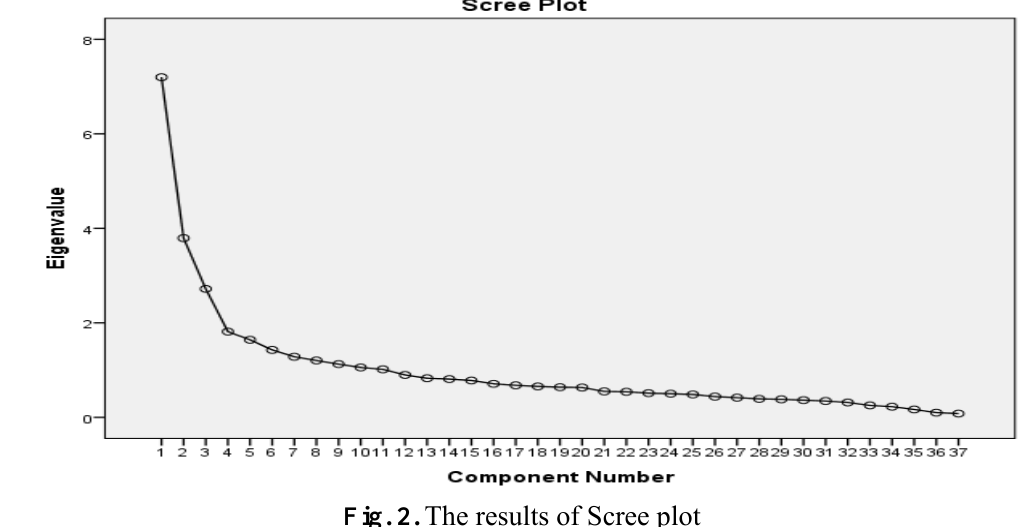
Fig. 2. The results of Scree plot